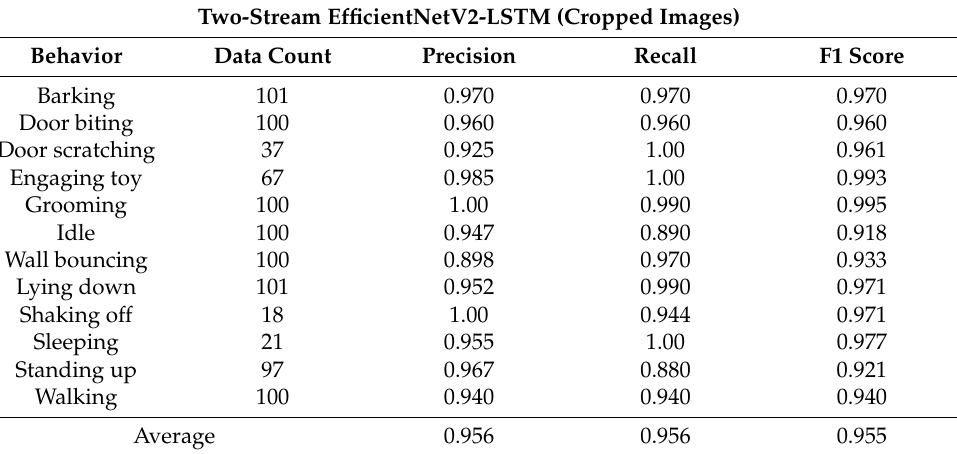
Table 6. Proposed method behavior recognition performance using precision, recall and F1 score. Two-Stream EfficientNetV2-LSTM (Cropped